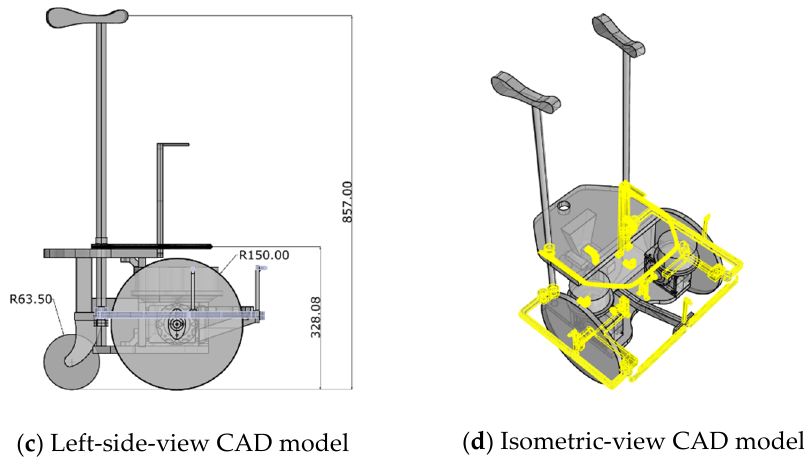
Figure 1. Computer-aided design (CAD) views of the prototype (dimensions in millimetres).